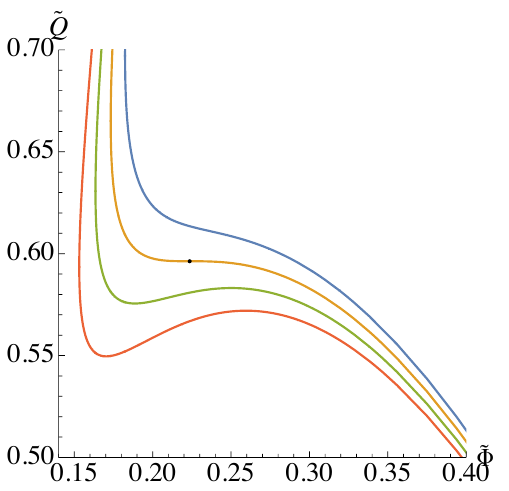
˜Φ plane around the critical point (black dot) for ˜ Q −